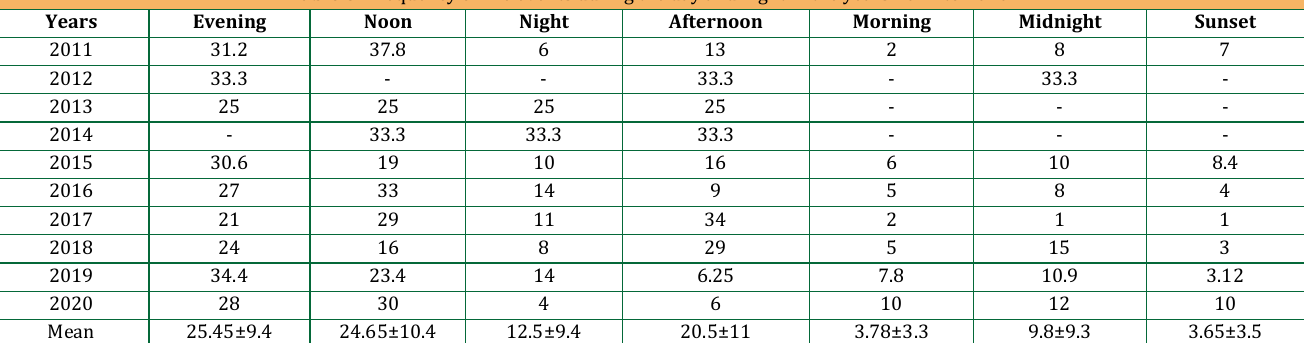
Table 5: Frequency of fire events during the day and night in the years 2011 to